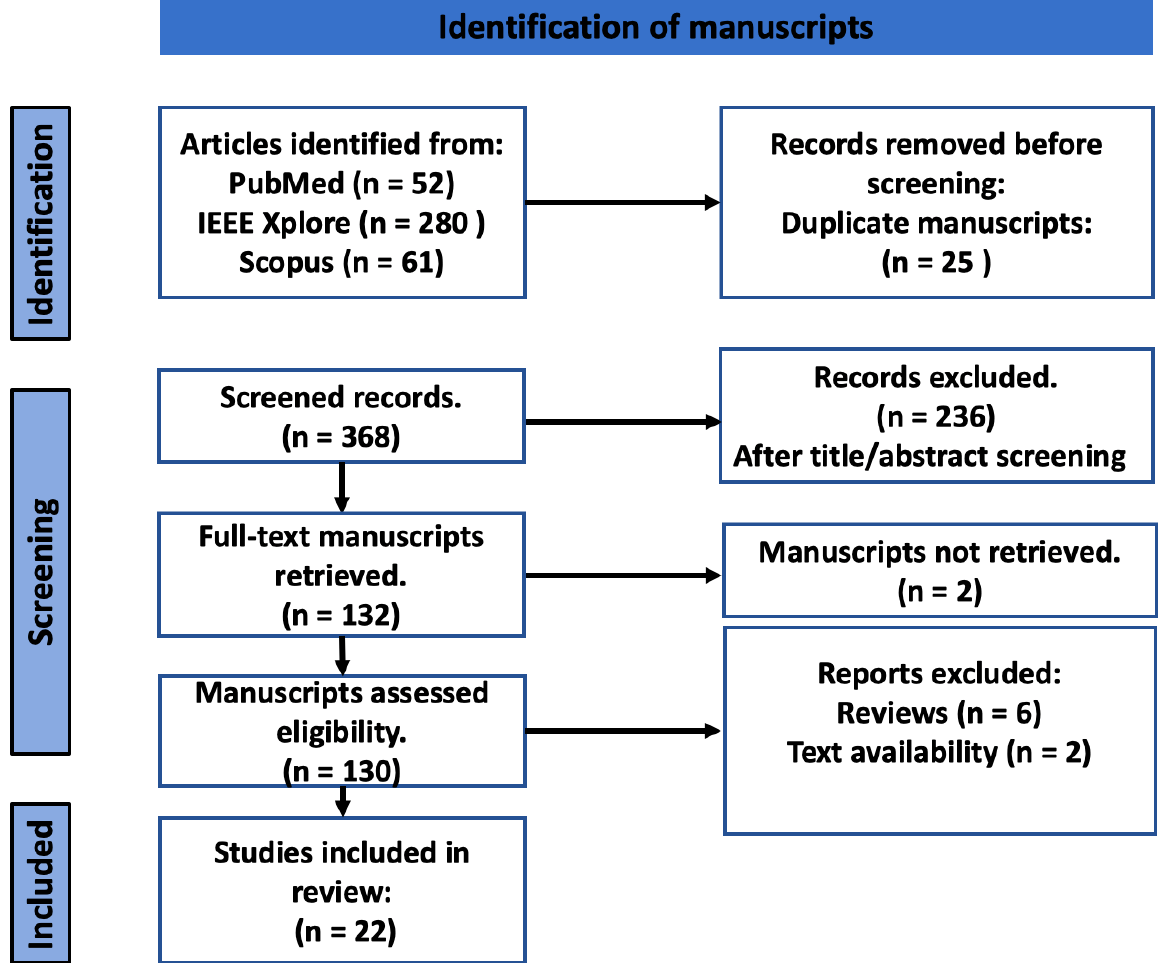
Figure 2. The diagram illustrates the PRISMA workflow.